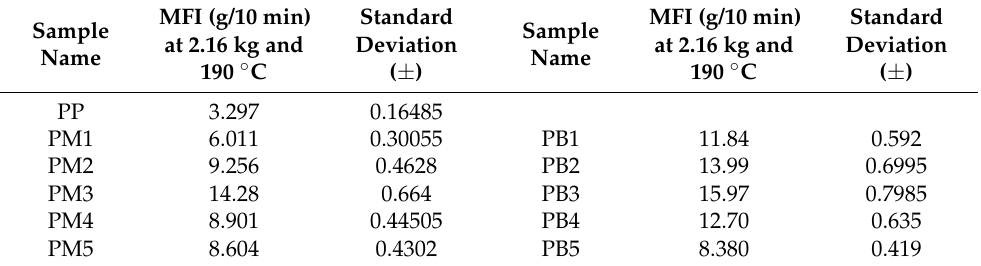
Table 4. Melt flow index for processed samples and pure PP.